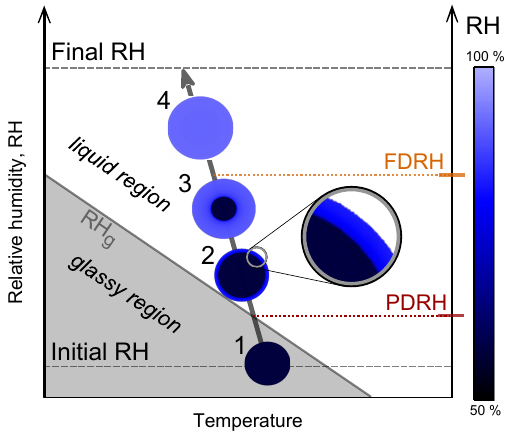
Figure 1. Schematic temporal evolution of particle morphology along a trajectory of an atmospheric updraft (grey arrow). Humid- ification of ambient air upon adiabatic expansion leads to lique- faction of initially glassy particles (dark blue colour, 1) via core- shell morphologies (2, 3) to liquid particles (light blue colour, 4). Whereas partial deliquescence (PDRH) coincides with RH g , full deliquescence (FDRH) is delayed to much higher RH, indicating that diffusion processes occur on much longer timescales than hu- midification. The speed at which particles are humidified along the displayed trajectory corresponds to that typical of cloud chamber or environmental cell experiments (0.1–1.5Kmin − 1 , 1–15% RH min − 1 )